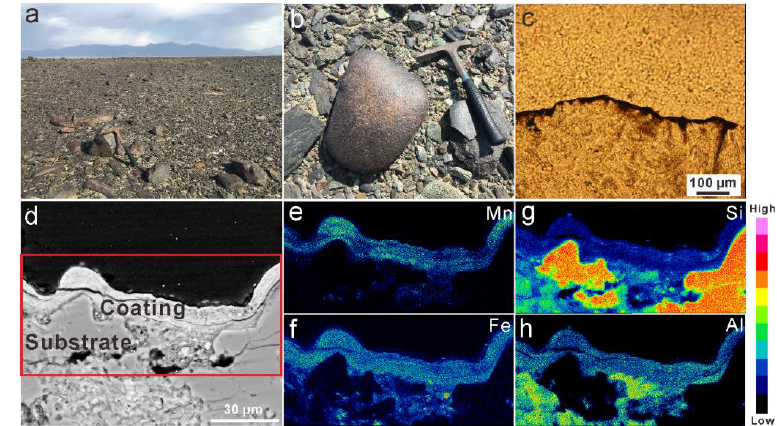
Figure 8. Field occurrence ( a ), hand specimen ( b ), optical image ( c ), back-scattered image ( d ) and elemental distribution patterns ( e – h ) of the rock Fe/Mn coating. The rectangle in panel ( d ) indicates the EDS mapping region.